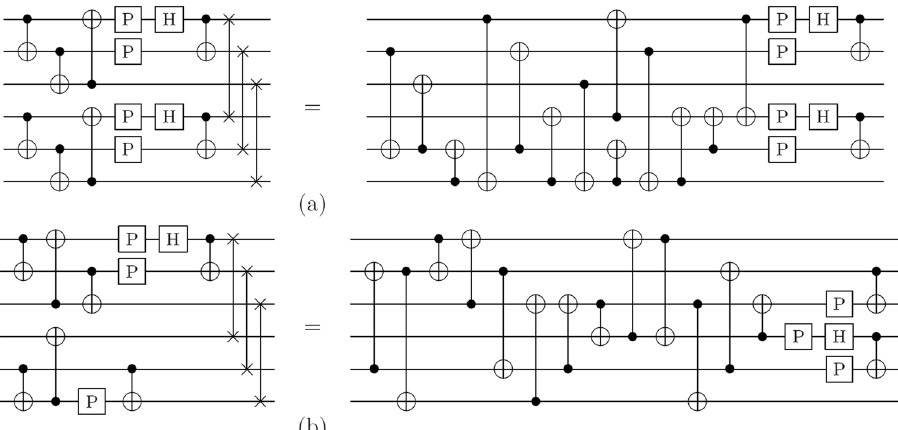
Fig. 1 All most expensive 6-qubit Clifford unitaries requiring 15 entangling gates (up to left and right multiplication by the single-qubit gates and qubit relabeling). a left: a compact representation in the form ( U ⊗ U )SWAP, right: its optimal implementation. b left: a compact representation in the form ð U 0 (cid:4) V 0 Þ SWAP , right: its optimal implementation. Not illustrated is the cyclic SWAP of all 6 qubits, that also requires 15 entangling gates. Table 1. The distribution of the number of 6-qubit Clifford unitaries across the entangling gate